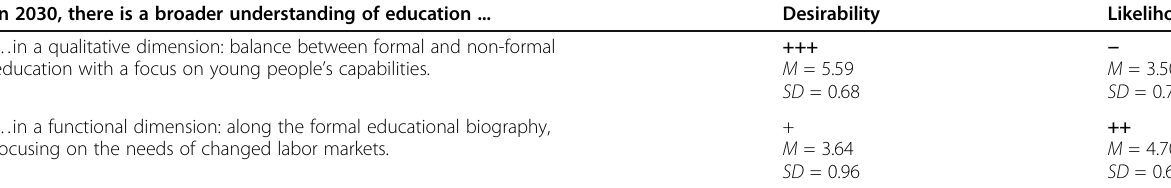
Table 5 Means and standard deviations for statements on expanding education In 2030, there is a broader understanding of education